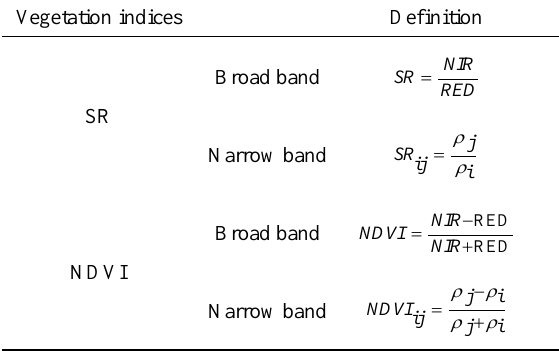
Table 1: Spectral vegetation indices used in this paper Where NIR = Landsat ETM+ B4 bands RED = Landsat ETM+ B3 bands.